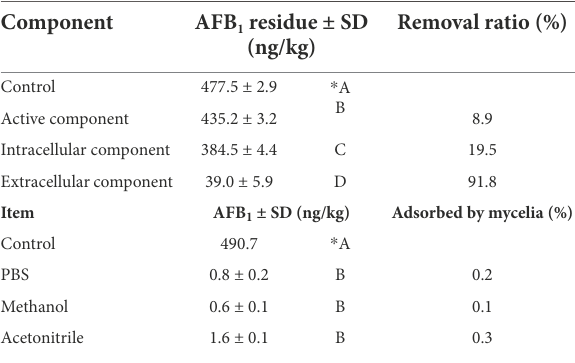
TABLE 1 Difference of AFB 1 removal ability among diverse cell components.